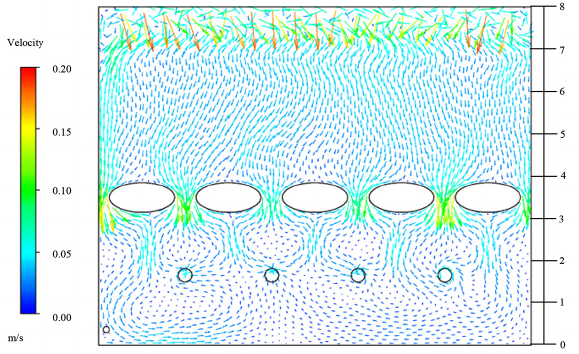
Figure 5. The vector diagram demonstrating the distribution of air velocity within the capacity of a winter garden